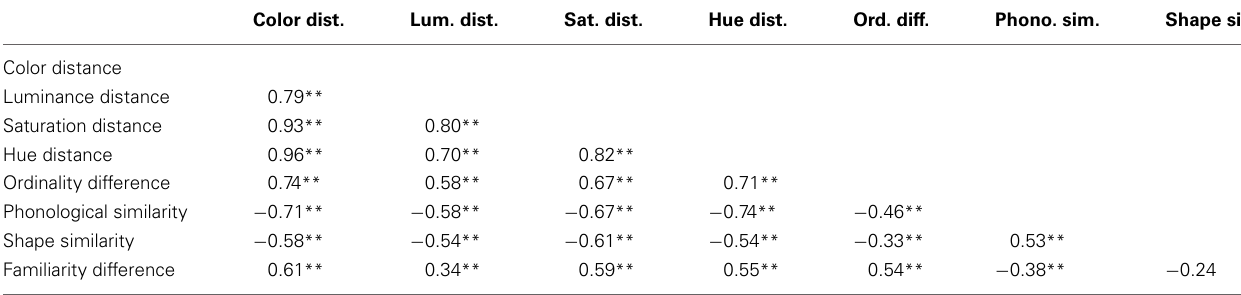
Table 1 | Correlations among the variables for Hiragana characters ( N = 69). Color dist.